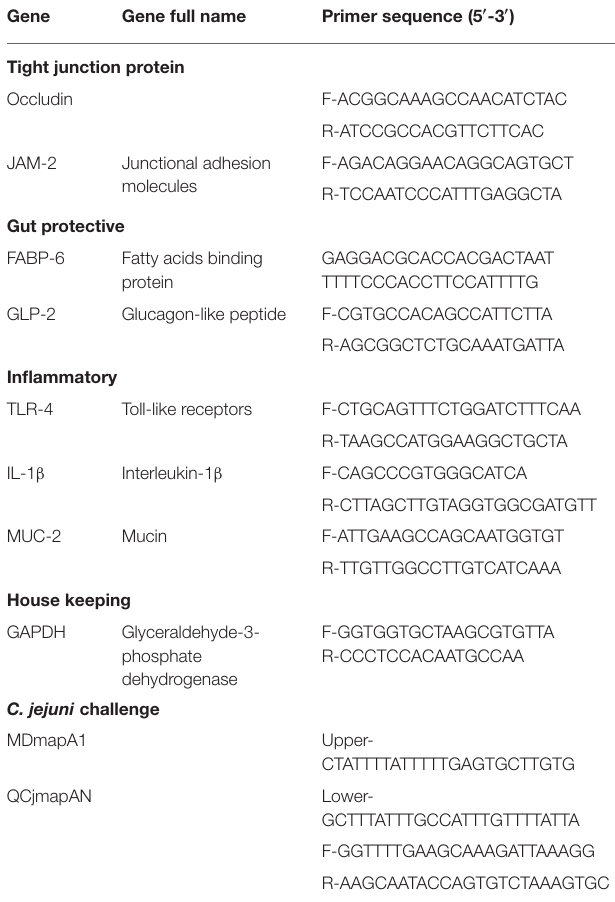
TABLE 2 | Primer sequences and target genes used for real-time PCR